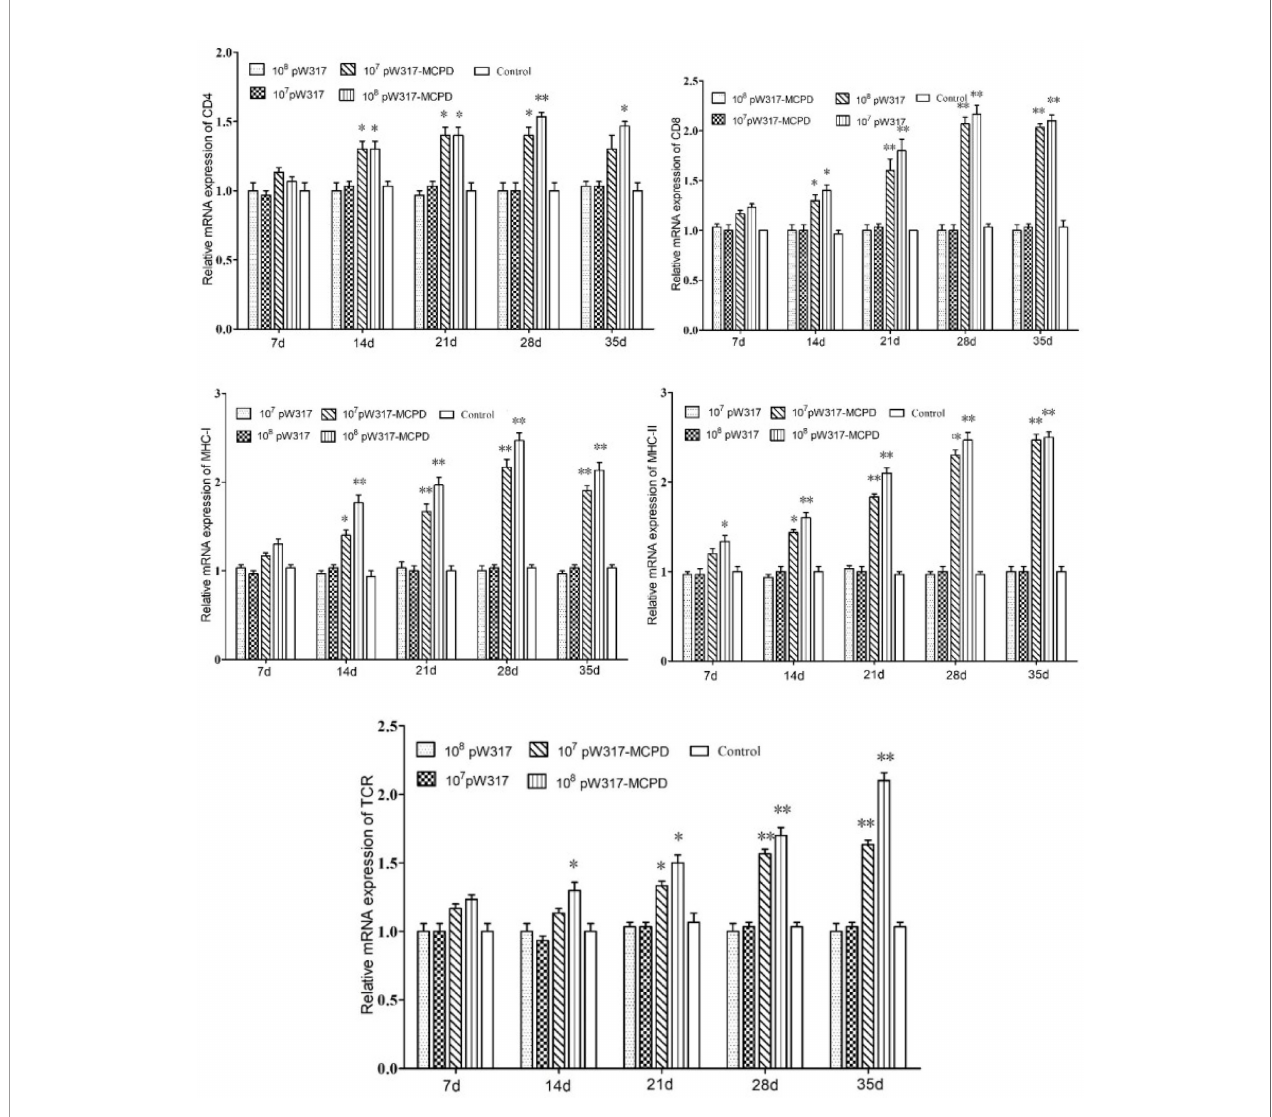
FIGURE 4 | The expression level of antigen presentation-related gene in gill after immunization. 10 7 pW317: 10 7 CFU/g GS115-pW317; 10 8 pW317: 10 8 CFU/g GS115-pW317; 10 7 pW317-MCPD: 10 7 CFU/g GS115-pW317-MCPD; 10 8 pW317-MCPD: 10 8 CFU/g GS115-pW317-MCPD. **P < 0.01; *P <